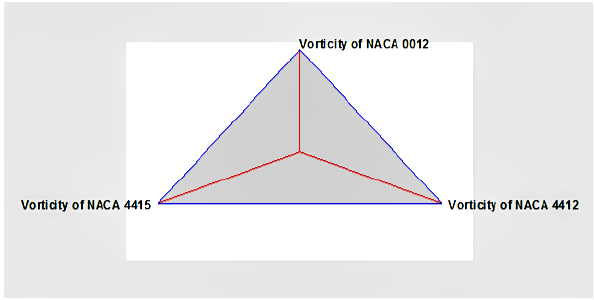
Figure 11. Star plot showing vorticities for NACA airfoils.